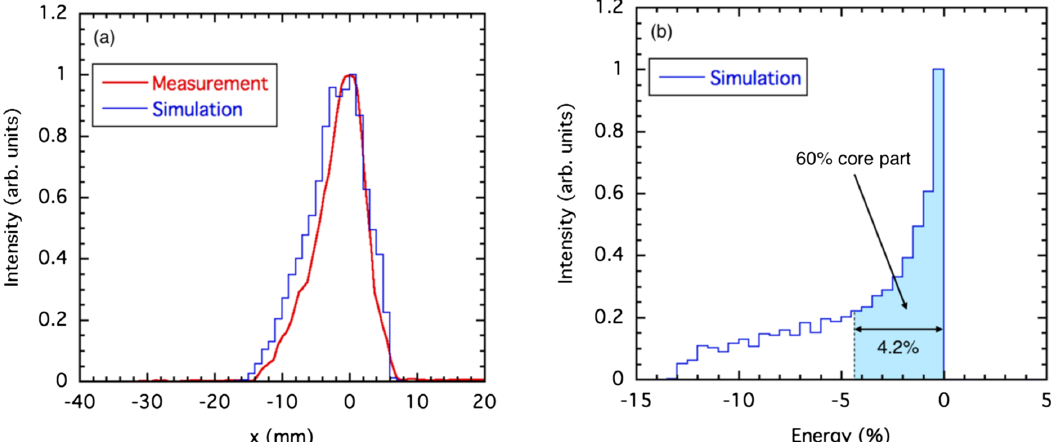
FIG. 11. (a) Measured (red line) and simulated (blue line) beam profiles at energy dispersive section downstream the 238-MHz rf cavity. (b) Energy profile at energy dispersive section downstream the 238-MHz rf cavity obtained with PARMELA simulation.